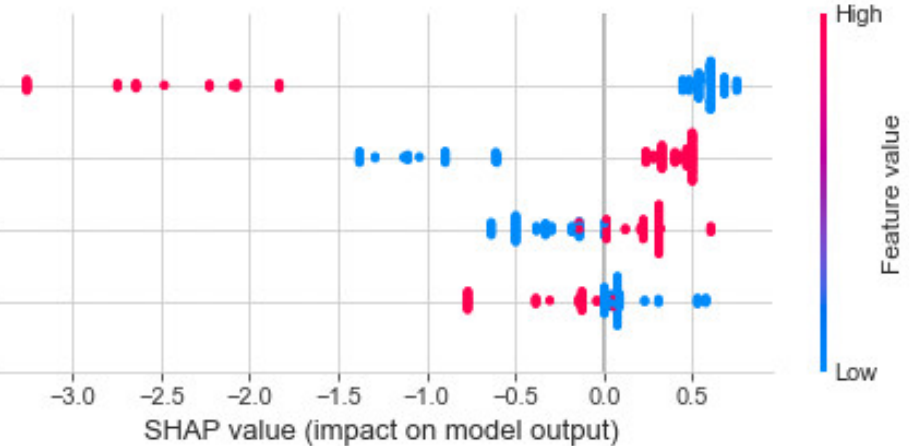
Figure 6. Shapley values for social variables.